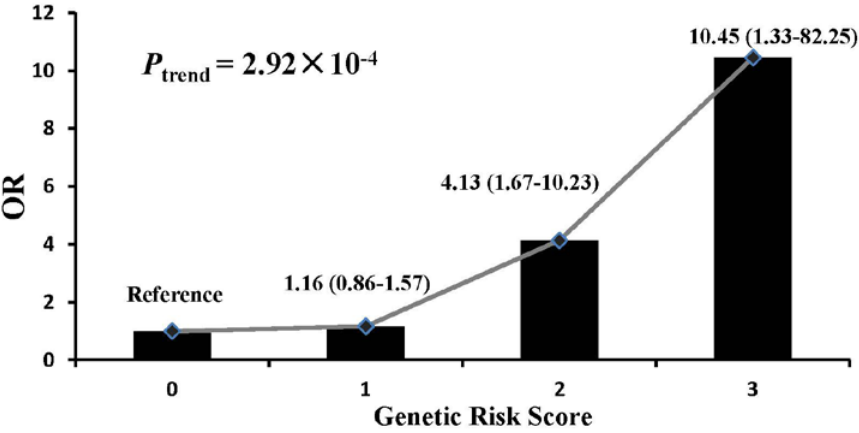
Figure 1. Cumulative effects of risk CNV loci on obesity. GRS ( X -axis) was the sum of the CNV risk alleles of the three positive loci (11q11, 10q11.22, 4q25). Odds ratio ( Y -axis) was calculated by logistic regression adjusted for gender and age, using the group with no risk type of the three loci as reference. The P trend was calculated by Chi-square trend